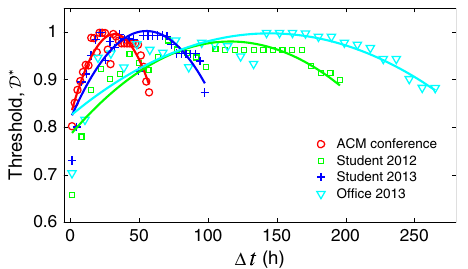
Fig. 6 The threshold for the outbreak of defection on temporal networks reaches its maximum at the intermediate aggregation time windows. For all empirical datasets we considered, the corresponding thresholds governed by Equation (3) are presented numerically in scatter plots over the different aggregation time windows Δ t . The corresponding lines are given by least square quadratic regression with R 2 > 0 : 7. Note that, for each dataset, the maximum Δ t is the total time the corresponding dataset covers (see Supplementary